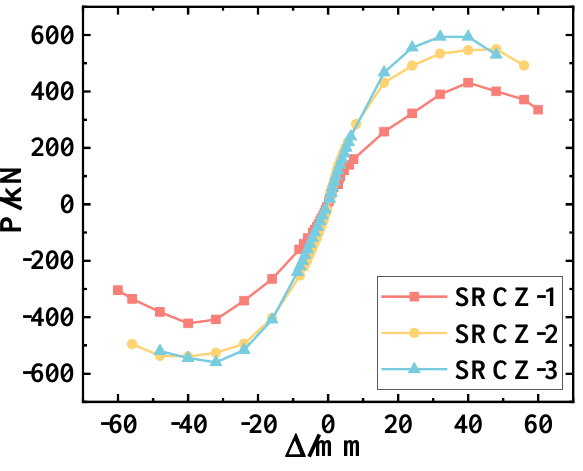
Figure 8. The Skeleton Curves.